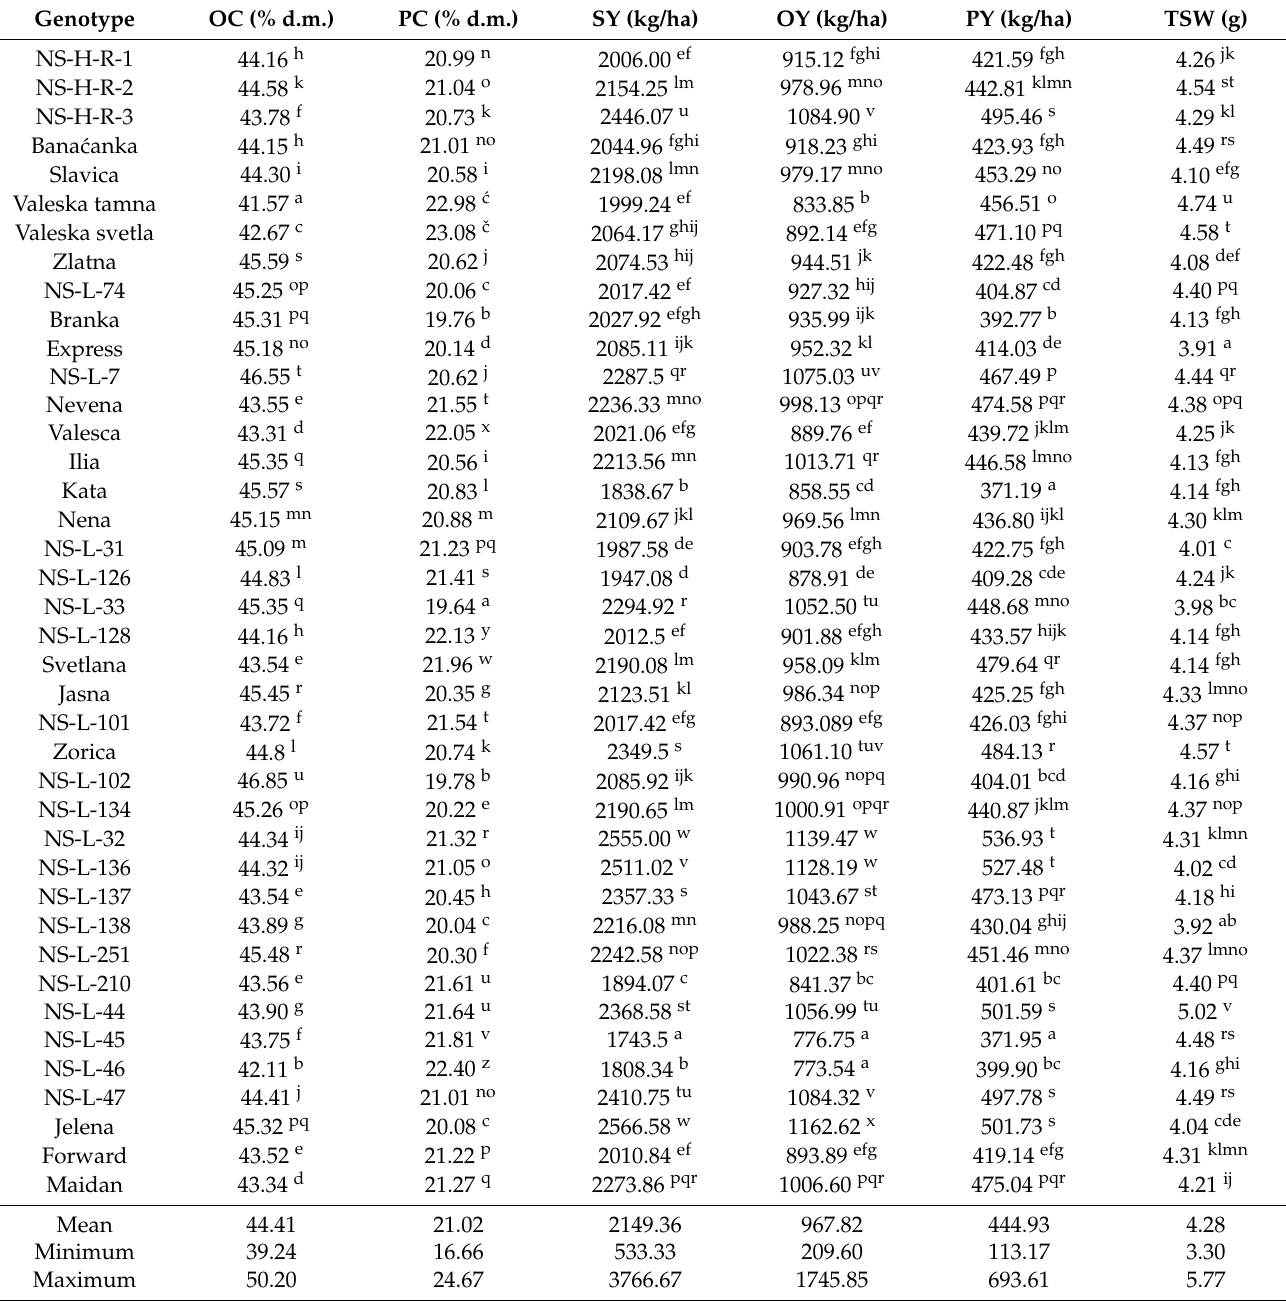
Table 2. Mean genotypic values for six analysed traits during four-year